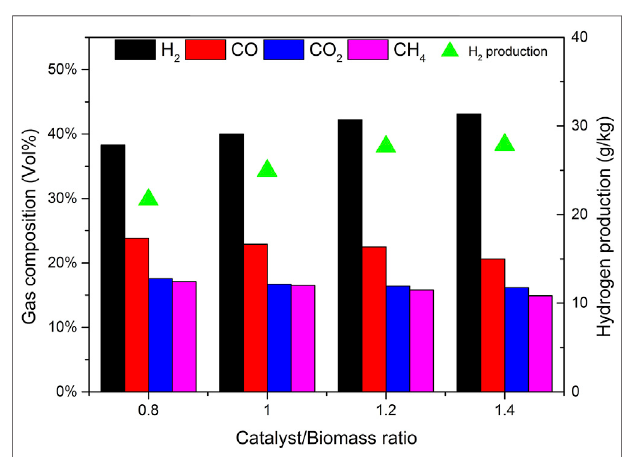
FIGURE 9 | Effect of CBR on gas composition and hydrogen production.